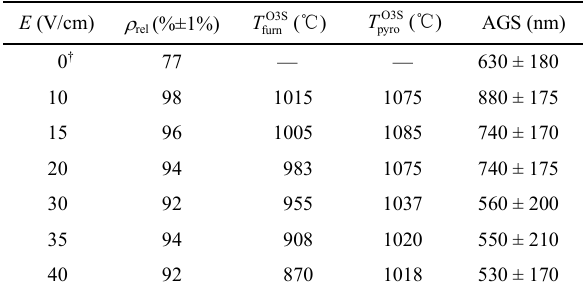
Fig. 2 Temperature dependence of (a) current density ( J ) and (b) true linear shrinkage during CCTO processing under electric field ( E ) input. The current density limits were J = 42.0 mA·mm − 2 for 10 V·cm − 1 ≤ E ≤ 40 V·cm − 1 and J = 22.0 mA·mm − 2 for E ≥ 60 V·cm − 1 . Inset in (a): magnification of the current data towards lower temperatures. The indicated points (a) to (g) represent different instants during material processing (and are discussed in the text). Table 1 Applied electric field ( E ), relative density ( ρ rel ), T ) temperatures T ) and pyrometer ( O3S furnace ( O3S pyro furn measured at flash (while allowing the imposed maximum current across the sample to last 1 min before turning off the power supply), and average grain size